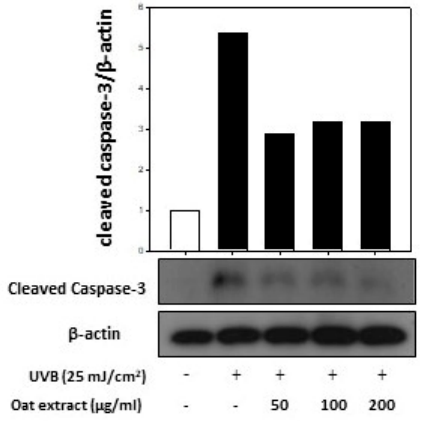
Figure 7. Effect of oat ( Avena sativa, cv. Daeyang) 80% ethanol extract on cleaved caspase-3 protein level in human keratinocytes HaCaT. Cells were treated with various concentrations (50–200 µ g/mL) of oat 80% ethanol extracts for 24 h, followed by incubation for 5 h after exposure of 25 mJ/cm 2 UVB. Cleaved caspase-3 protein level was assessed using immunoblotting. β -Actin was used as an internal control.